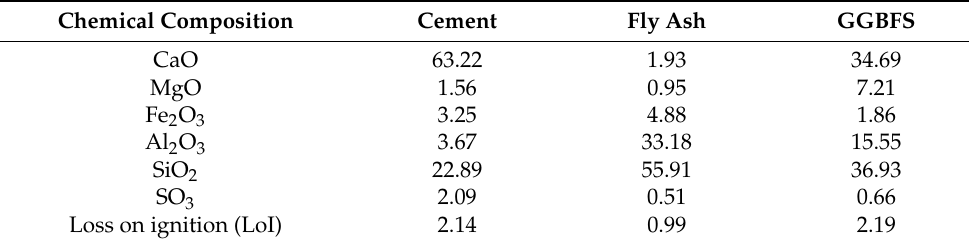
Table 1. Chemical compositions of cement, fly ash, and GGBFS (wt.%).